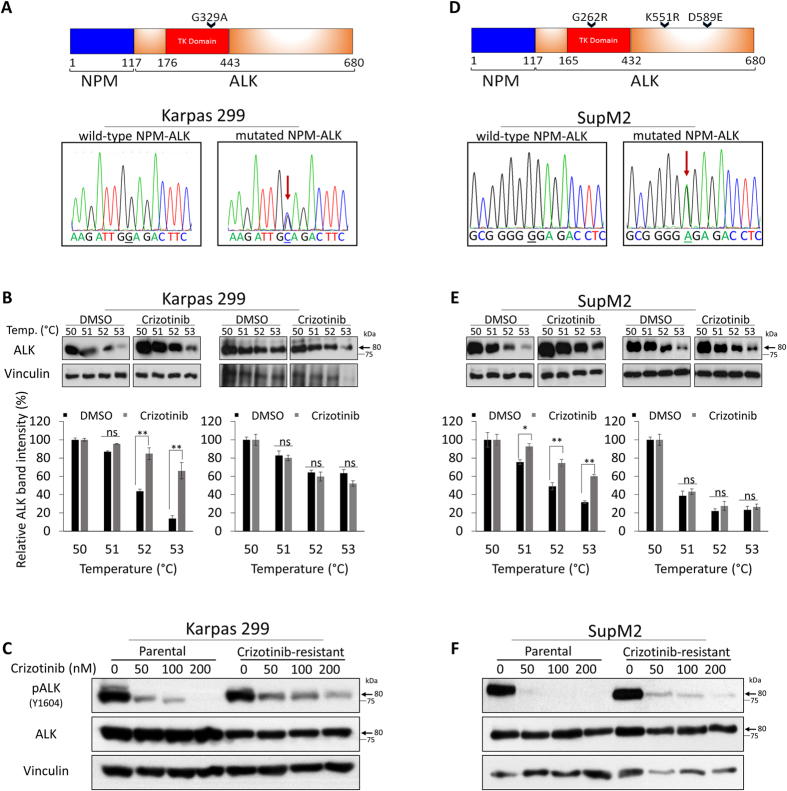
Identification of NPM-ALK secondary mutations in Crizotinib-resistant ALK+ALCL cell lines that abrogate the binding between Crizotinib and ALK.(A) Sequencing of ALK kinase domain coding fragment in Crizotinib-sensitive and Crizotinib-resistant ALK+ALCL cell lines. Schematic of ALK kinase domain mutations associated with acquired resistance to Crizotinib. (A,D) Show the electropherograms of NPM-ALK cDNA from parental Karpas 299, Crizotinib-resistant Karpas 299, parental SupM2, and Crizotinib-resistant SupM2 cells. (B,E) Show that Crizotinib—ALK binding can be detected using CETSA assay in Crizotinib-sensitive cells but not in Crizotinib-resistant clones (full-length blots are presented in Supplementary Figure 12). (C,F) Show that Crizotinib treatments could substantially inhibit pALK in Crizotinib-sensitive cells, while only partially inhibit pALK in Crizotinib-resistant clones.